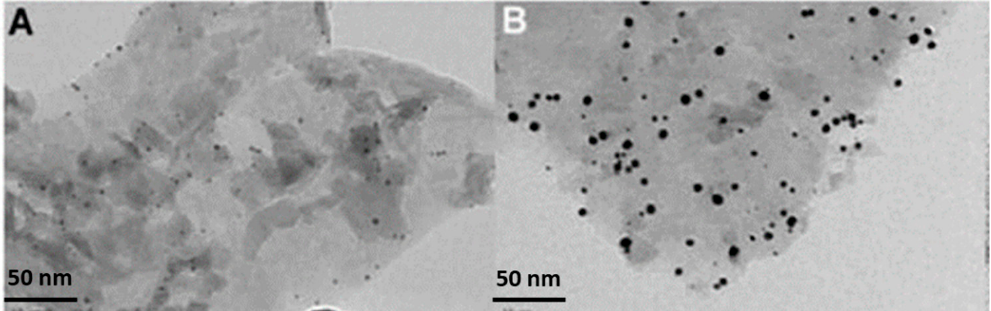
Figure 3. TEM images of Au and Ag loaded g-C 3 N 4 nanomaterials ( A , B ) [40].